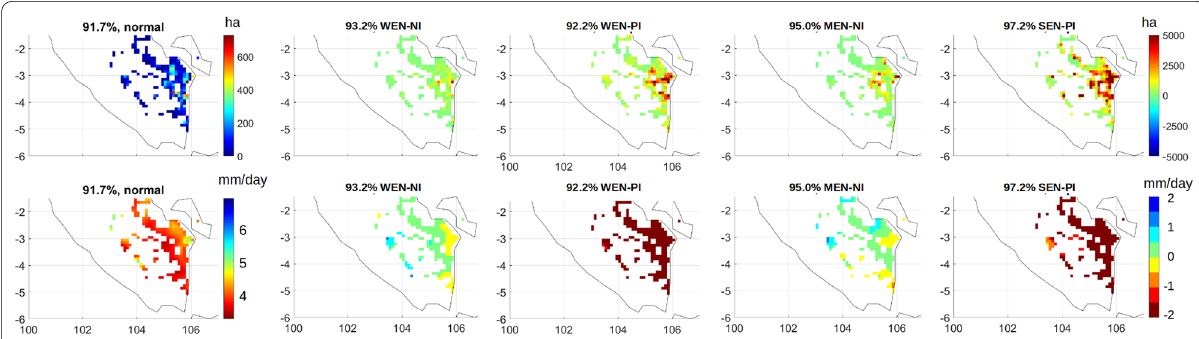
Fig. 8 Spatial of joint Pattern from each category on South Sumatra. In a normal graph, the colour represents an average of total burned area for each grid in the composite year only during fire season (July–November). Other categories represent the difference between each category with value in a normal